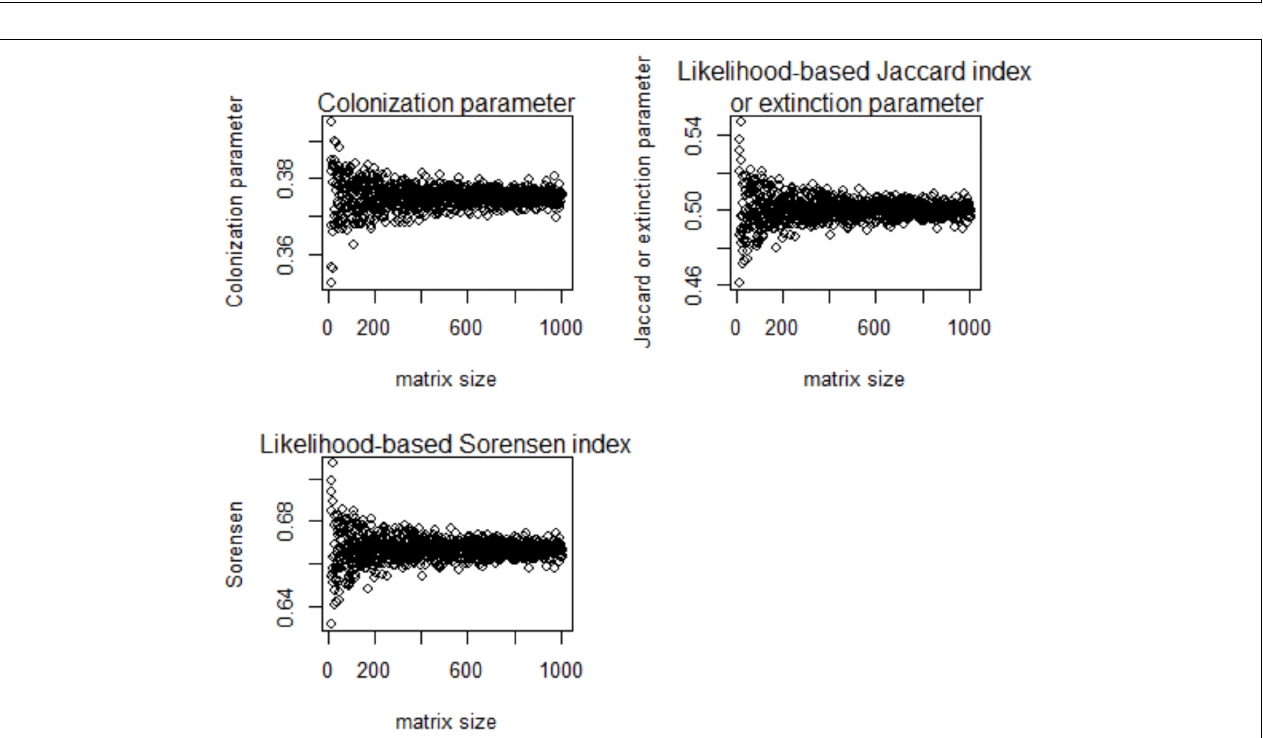
FIGURE 3 | Relationships of the colonization rate and extinction rate with multi-site beta diversity indices inferred using the proposed likelihood model and species richness (labeled as “matrix size”) in a numerical simulation.